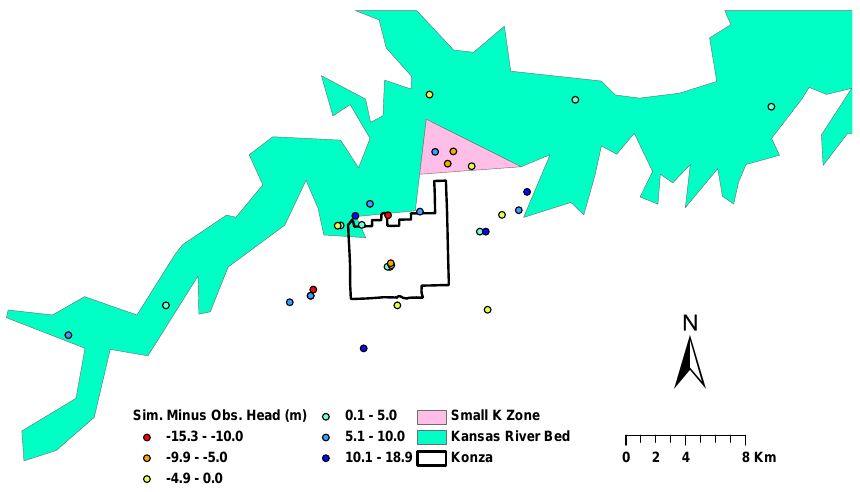
Fig. 6. Groundwater observation wells and differences between simulated and observed heads. database, which contain wells periodically measured by the Kansas Geological Survey and the USGS. The location of twenty three wells are identified in the Kansas WWC5 water well completion records. Additionally, two more were iden- tified in Lauwo (2007) and two other wells on Konza were measured including the well beneath the windmill shown in Fig. 1b. These wells are largely screened in or connected to the Morrill Limestone unit studied by Macpherson (1996). The relatively large number of observation wells and their placement in both the Kansas River valley and the Flint Hills helps substantiate the findings of this study (e.g. only three observation wells in the Kansas River valley were used by York et al.,